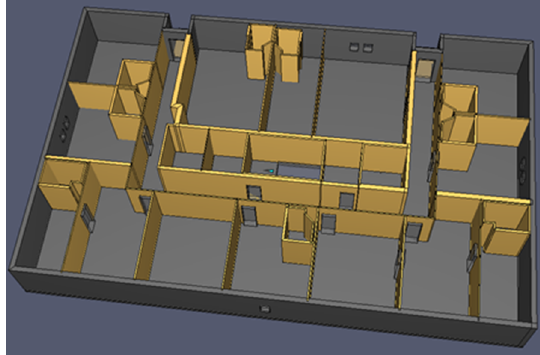
Figure 2. PyroSim model.